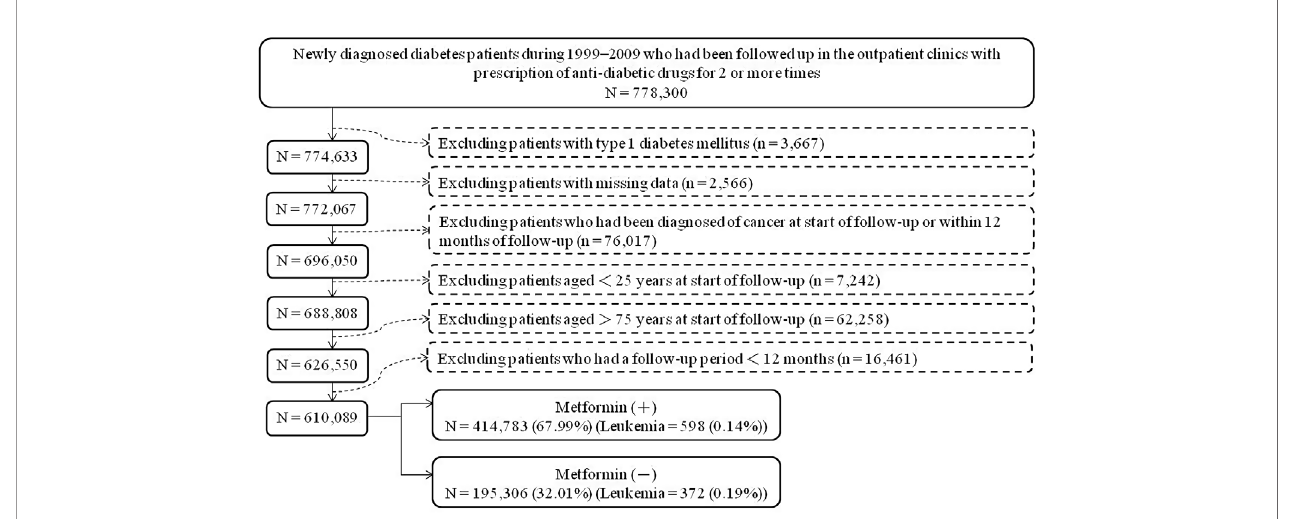
FIGURE 1 | Flowchart showing the procedures followed in creating a cohort of metformin initiators [Metformin (+)] and non-metformin initiators [Metformin ( – )] from the reimbursement database of Taiwan ’ s National Health